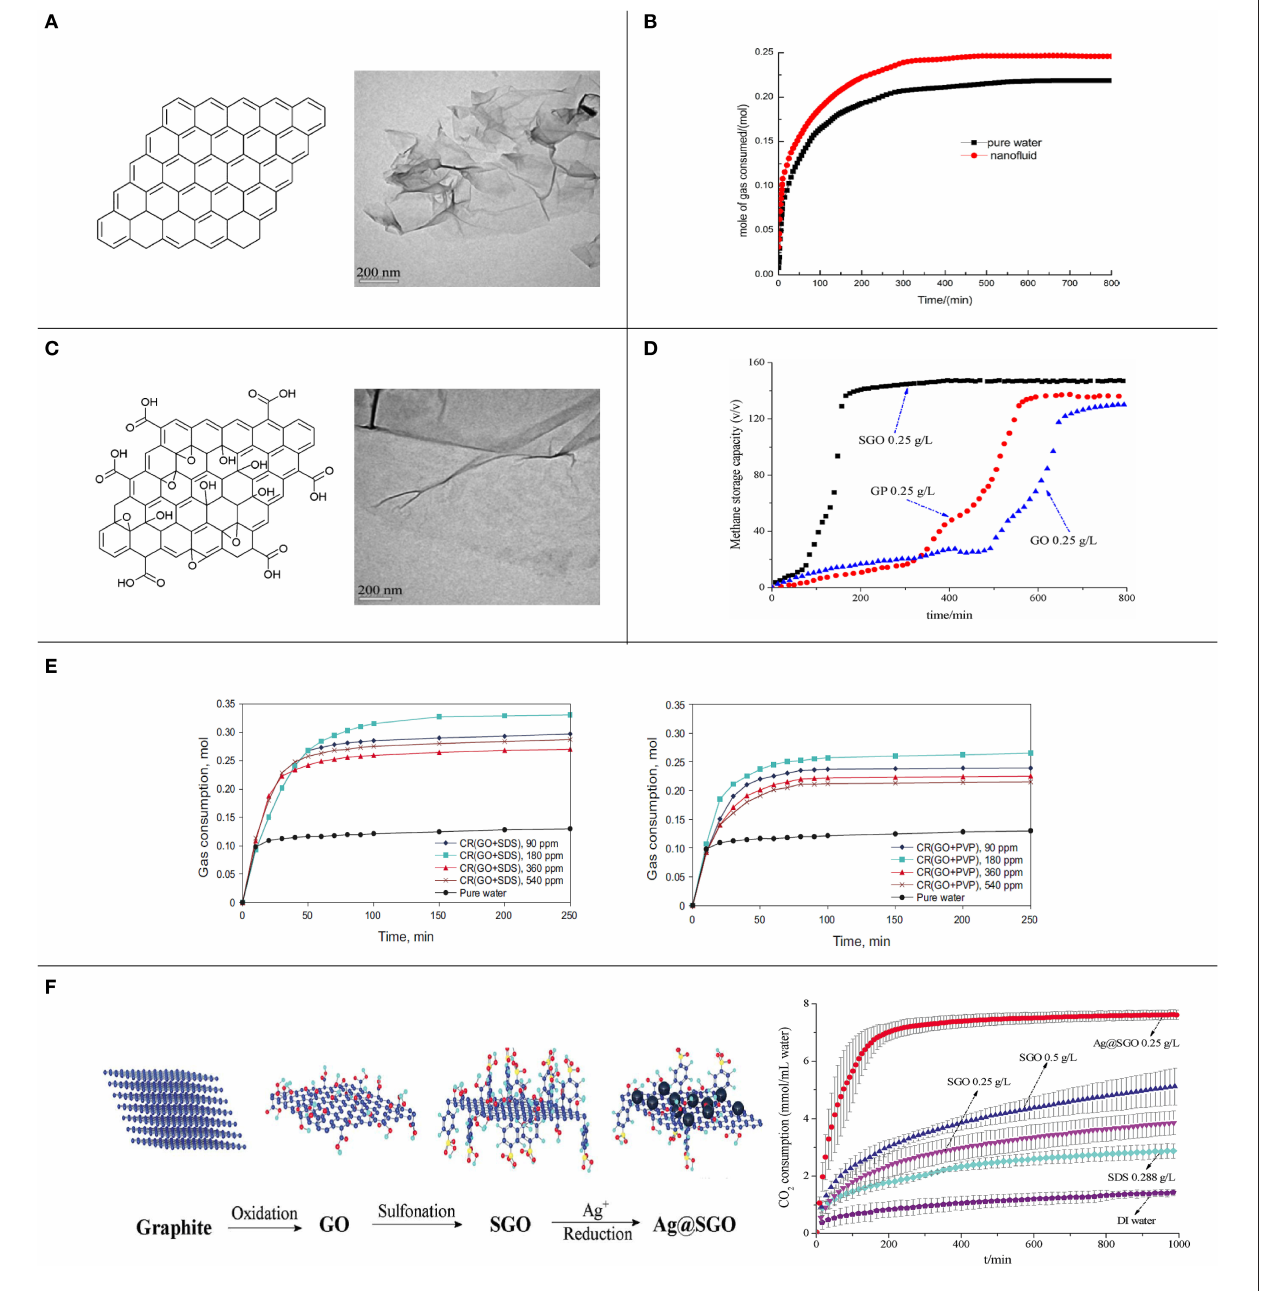
FIGURE 2 | (A) Structural diagram and TEM image of graphene; reproduced from Wang et al. (2017) with permission from the American Chemical Society. (B) Gas consumption during CO 2 hydrate formation with pure water and graphene nanofluid; reproduced from Zhou et al. (2014) with permission from the American Chemical Society. (C) Structural diagram and TEM image of GO; reproduced from Wang et al. (2017) with permission from the American Chemical Society. (D) Storage capacity during methane hydrate formation in the presence of graphene, GO, and SGO; reproduced from Wang et al. (2017) with permission from the American Chemical Society. (E) Gas consumption during methane hydrate formation at different concentrations of chemically RGO with SDS and PVP; reproduced from Abedi-Farizhendi et al. (2019b) with permission from the China University of Petroleum Beijing. (F) Structural diagram of graphite, GO, SGO, and Ag@SGO, and gas consumption during CO 2 hydrate formation with different promoters; reproduced from He and Wang (2018), which was previously conducted by us and originally published by the Royal Society of Chemistry. have admirable thermal and electrical properties as well films, photocatalysis, etc. (Kumar et al., 2019). Graphene, as presenting a nanostructure and a large specific surface graphene derivatives, and graphene-based composites are area ( Figure 2 collectively known as graphene-based materials, all of which